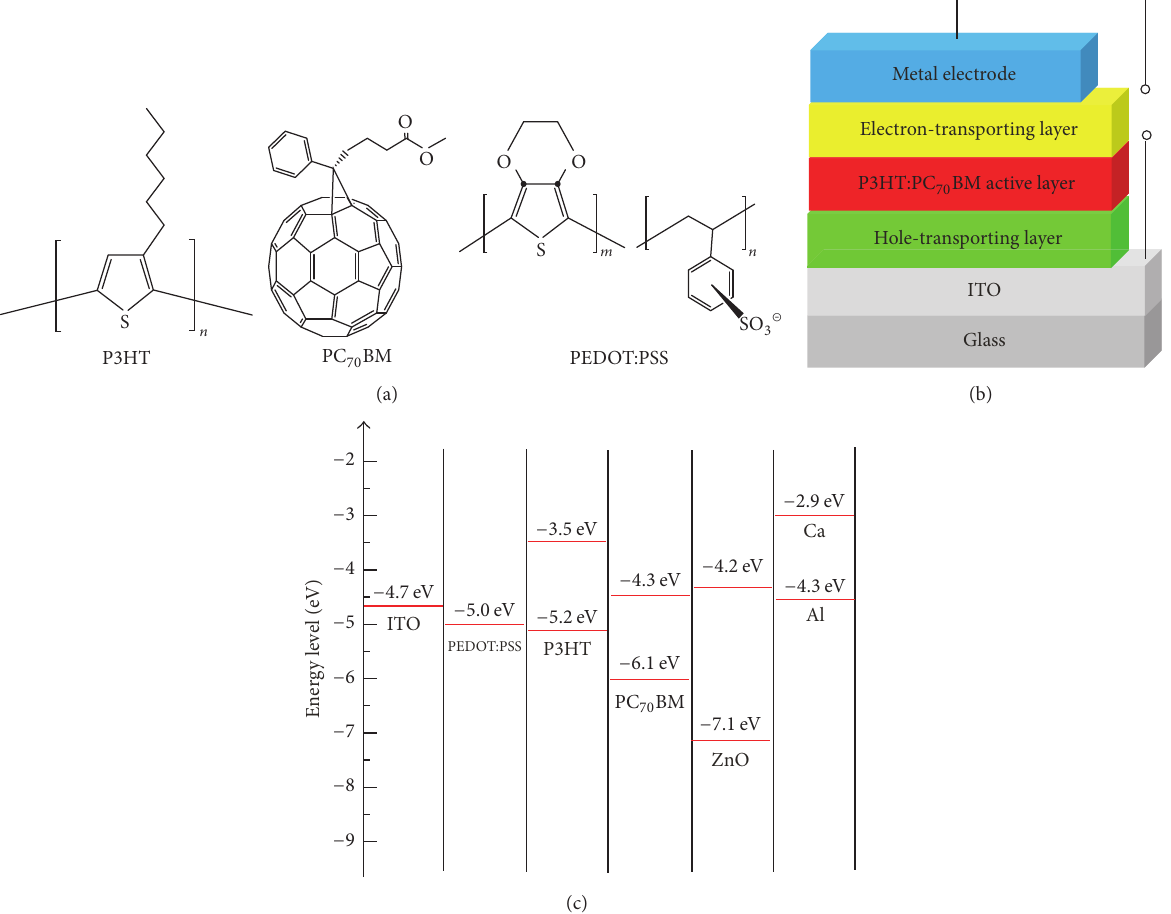
Figure 1: (a) The molecular structures of P3HT, PC 70 BM, and PEDOT:PSS. (b) The typical device structure of polymer solar cell based on P3HT:PC 70 BM. (c) Energy level diagram of the component materials used.